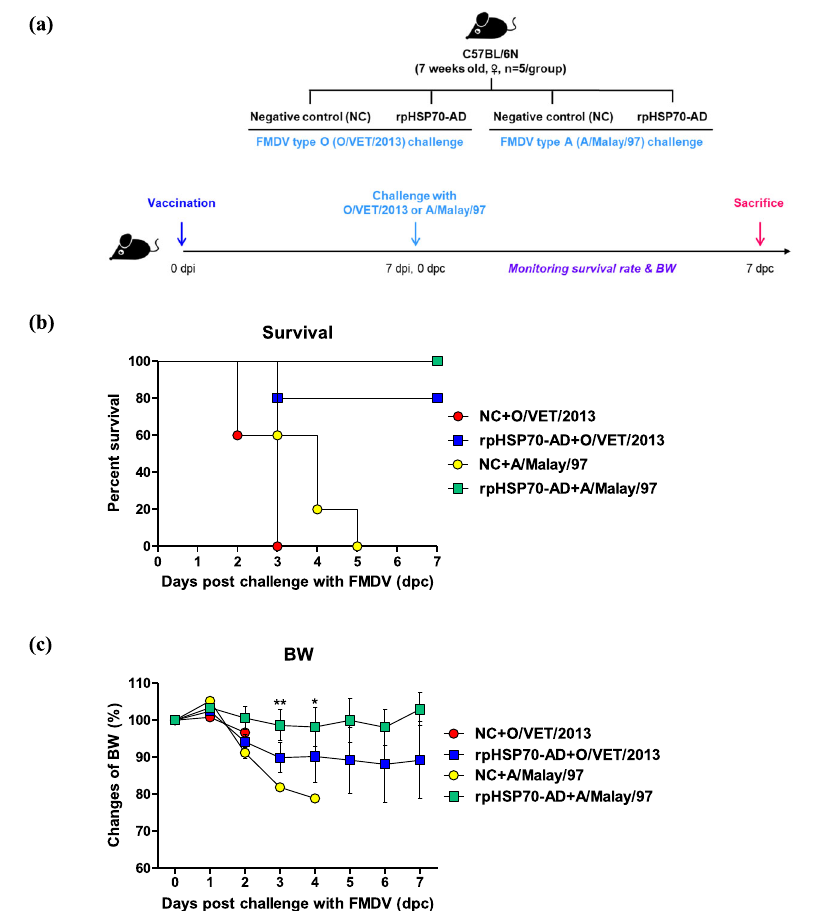
Fig. 3 rpHSP70-AD induced a broad spectrum of host protection against FMDV O (O/VET/2013) and FMDV A (A/Malay/97) infection in mice. C57BL/6 mice ( n = 5/group) were administered with test vaccine including 10 μ g rpHSP70-AD, ISA 206 (oil-based emulsion, 50%, w/w), 10% Al(OH) 3 , and 15 μ g Quil-A. A negative control (NC) group was injected with the same volume of PBS. The test vaccines were injected intramuscularly into mice that were later challenged with FMDV O (100 LD 50 O/VET/2013) and FMDV A (100 LD 50 A/Malay/97) at 7 days post- vaccination. The survival rates and body weights were monitored for 7 days post-challenge. Experimental strategy ( a ); survival rates post- challenge with O/VET/2013 and A/Malay/97 ( b ); changes in body weight post-challenge with O/VET/2013 and A/Malay/97 ( c ). The data represent the mean ± SEM of triplicate measurements ( n = 5/group). Statistical analyses were performed using two-way ANOVA with Bonferroni correction. * p < 0.05; ** p <